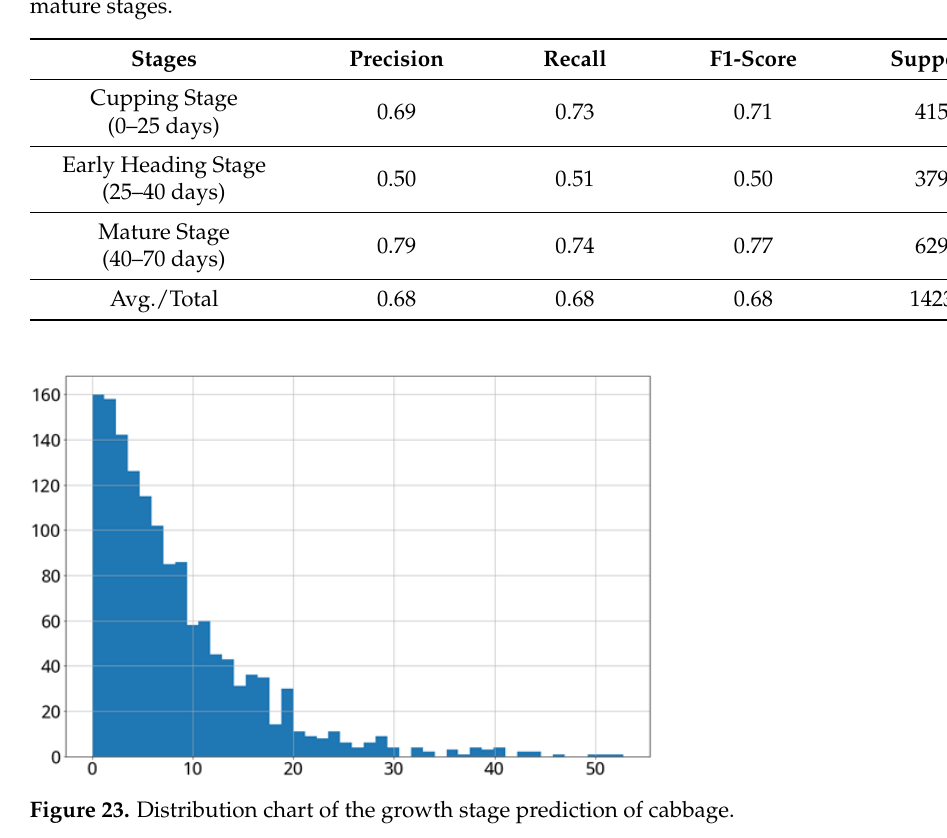
Table 10. Growth status classification results of cabbage from cupping, early heading, and mature stages.